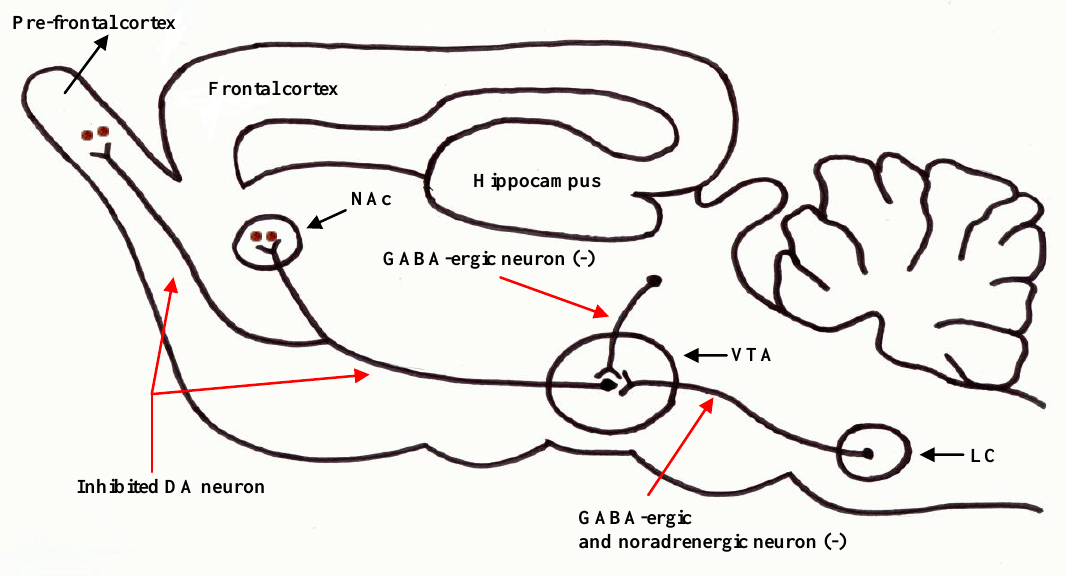
Figure 2 . Activity of meso-corticolimbic system in physiological condition (a), and during exogenous administration of GHB